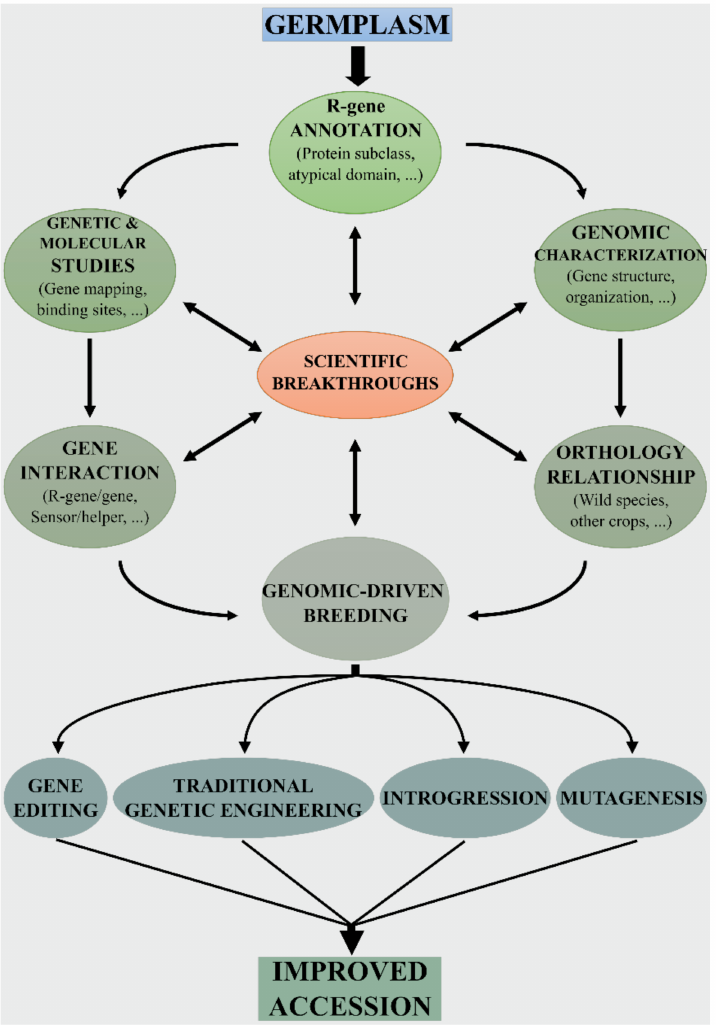
Figure 2. Genomic-driven breeding workflow for disease resistance. The identification, annotation, and characterization of NB-LRR genes are essential to investigate the extent of variability and compare the defense arsenals typical of each tomato/Solanaceae species. Information on gene- gene interaction provides additional evidence on the role and function of NB-LRRs. The different analytical approaches based on the most cutting-edge technologies must be combined to gain valuable knowledge on R-genes. The expanded knowledgebase is then used to apply the most appropriate genome-driven breeding technique to improve tomato disease